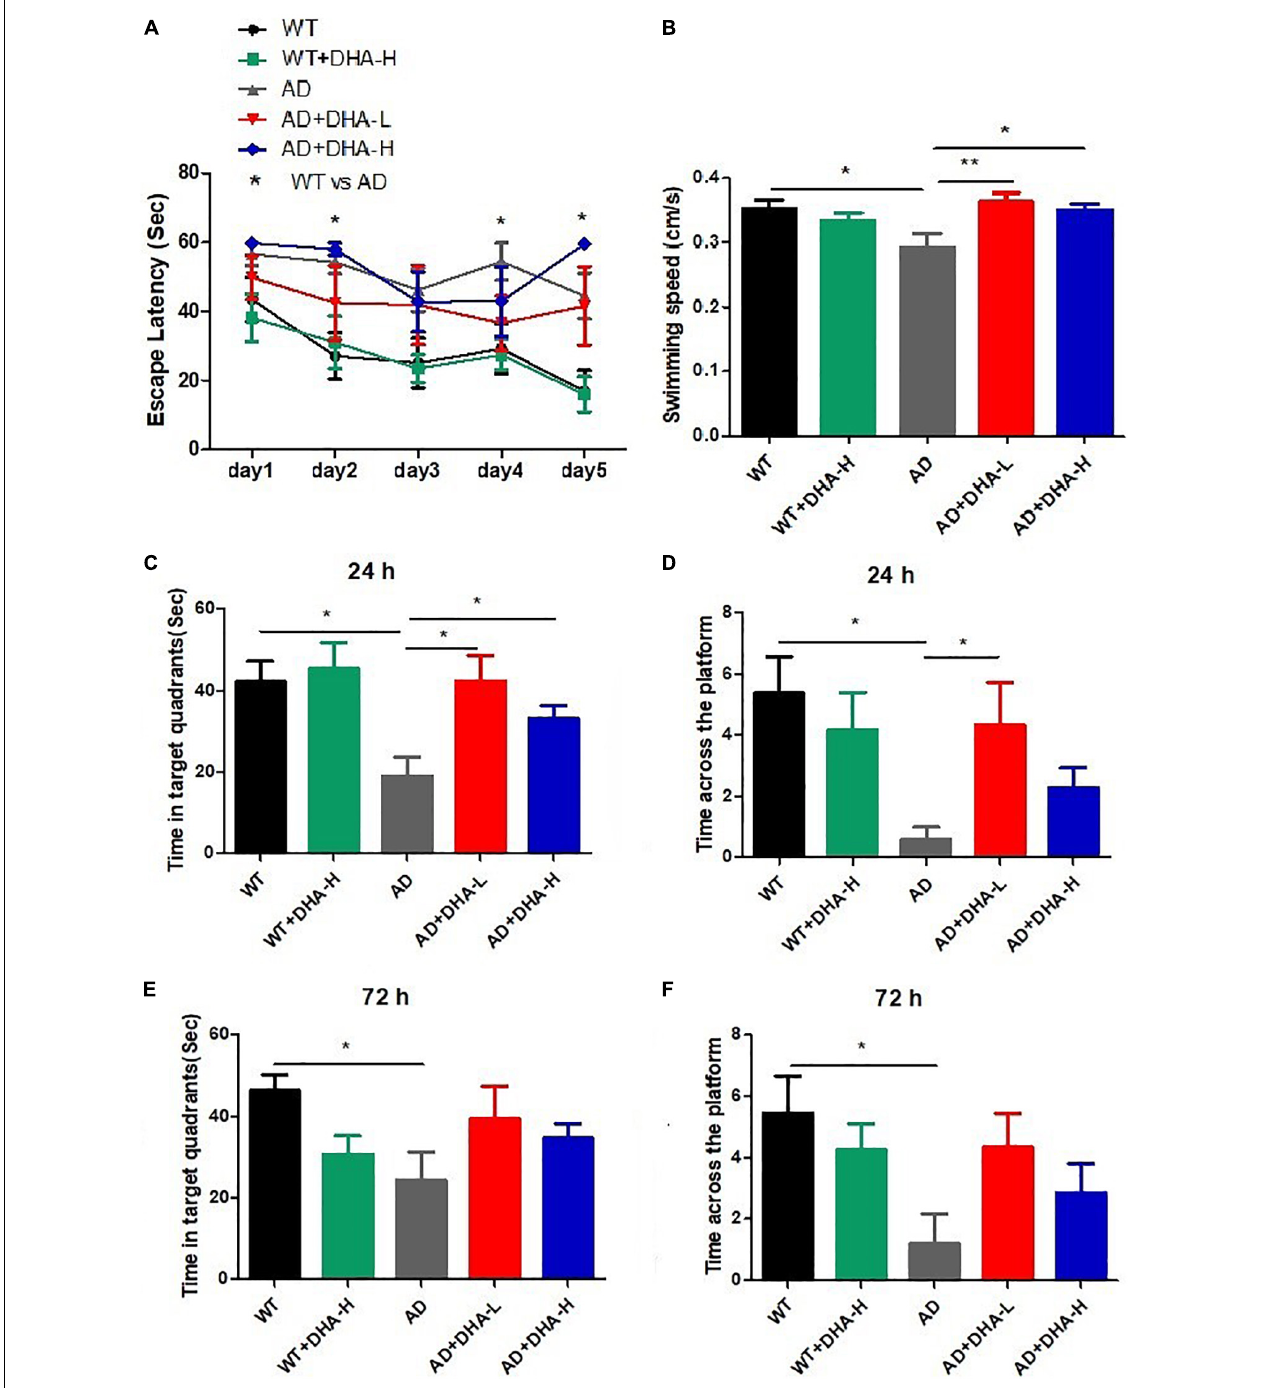
FIGURE 1 | Effect of DHA treatment for 4 months on spatial memory and learning ability in 2 × Tg AD mice. (A) Escape latency; (B) average swimming speed; (C) time in target quadrant 24 h after 5-day training; (D) times crossing platform 24 h after 5-day training; (E) time in target quadrant 72 h after 5-day training; (F) times crossing platform 72 h after 5-day training (* p < 0.05; ** p < 0.01). Student’s t test was used for statistical analysis. Error bars represent mean ± S.E.M. ( n = 12).